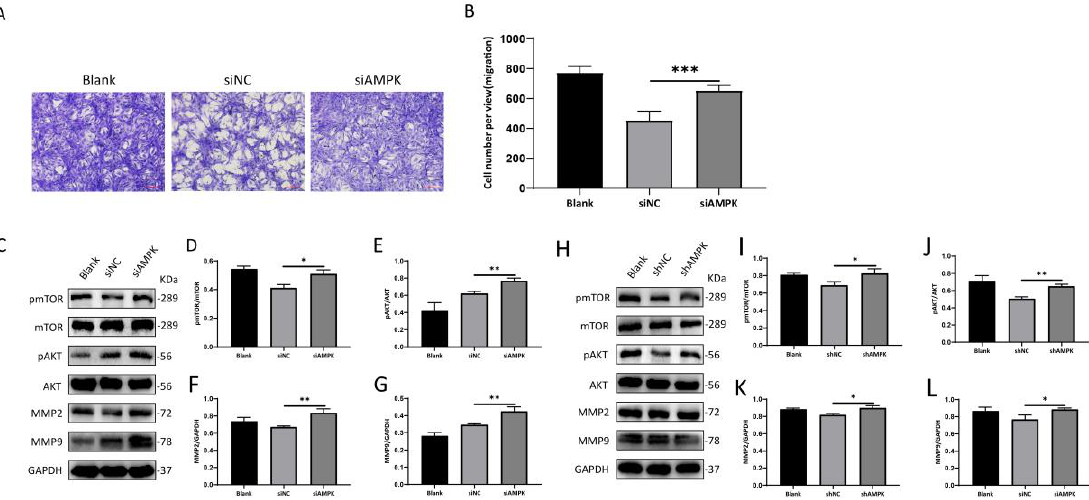
Figure 5. Knockdown of AMPK promotes the migration of NIH 3T3 cells. NIH 3T3 cells were incubated for 24 h. ( A , B ) The number of migrating cells was observed in five random fields under a 100× microscope. Scale bar = 100 μm . Cell migration was quantified using ImageJ/Fiji software. Values represent the means ± SEs of the numbers of migrating cells from three independent experiments. ( C – L ) Relative band densities of pmTOR/mTOR, pAKT/AKT, MMP2, and MMP9 are quantified in the bar graphs. All the experiments were performed in triplicate and repeated on at least three occasions. Data are shown as means ± SDs. * p < 0.05, ** p < 0.01, and *** p < 0.001. Blank: NIH 3T3 cells, siNC: siAMPK negative control group, siAMPK: NIH 3T3 cells transfected with si−Prkaa1−mus−1337, shNC: lentivirus AMPK negative control group, shAMPK: lentivirus AMPK knockdown group 1.